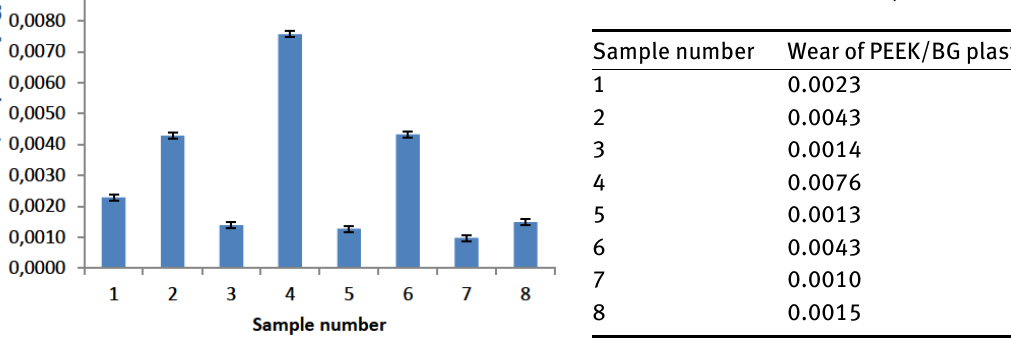
Table 3: The mass loss of PEEK/BG